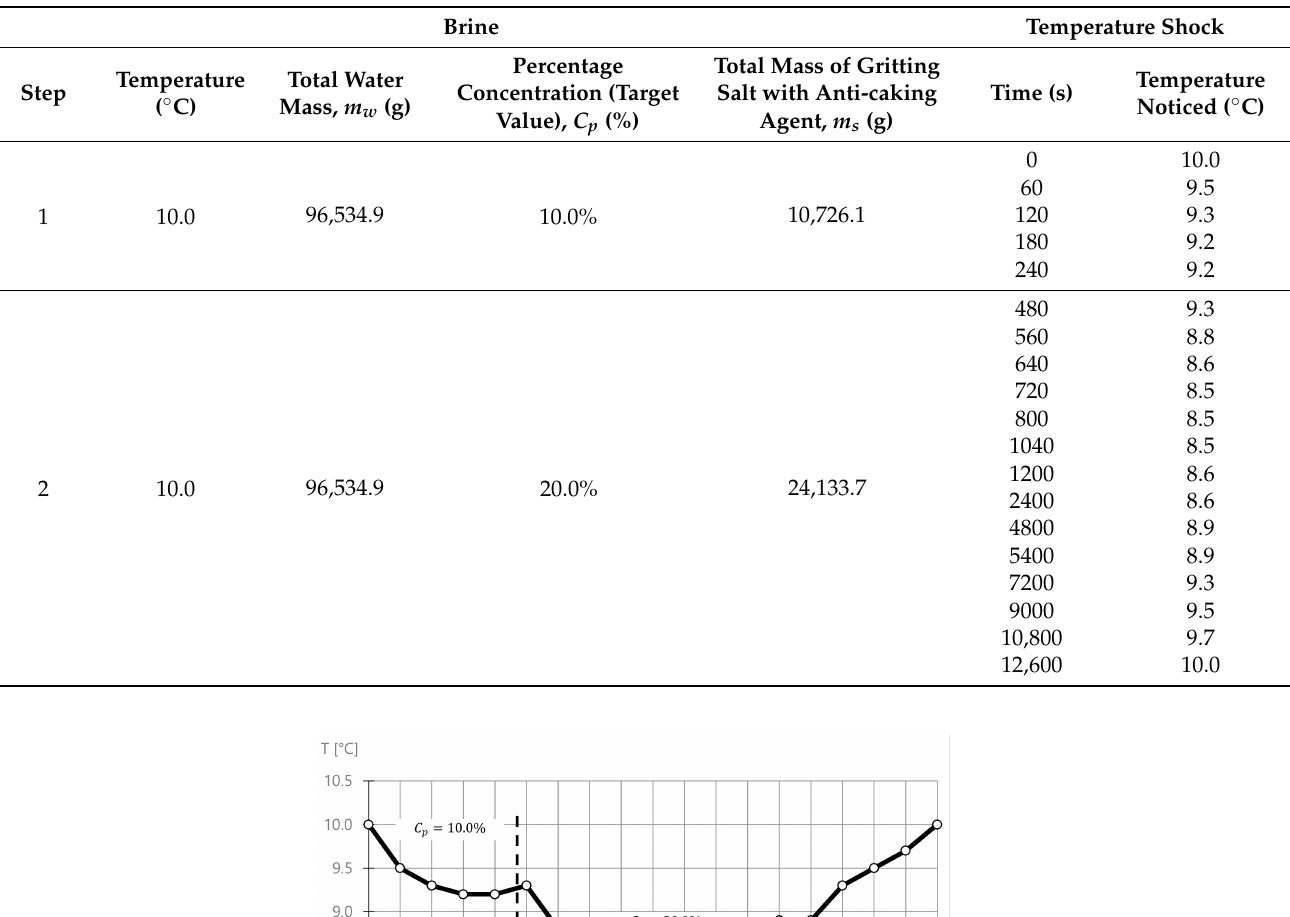
Table 2. Brine data and measured temperature variability.